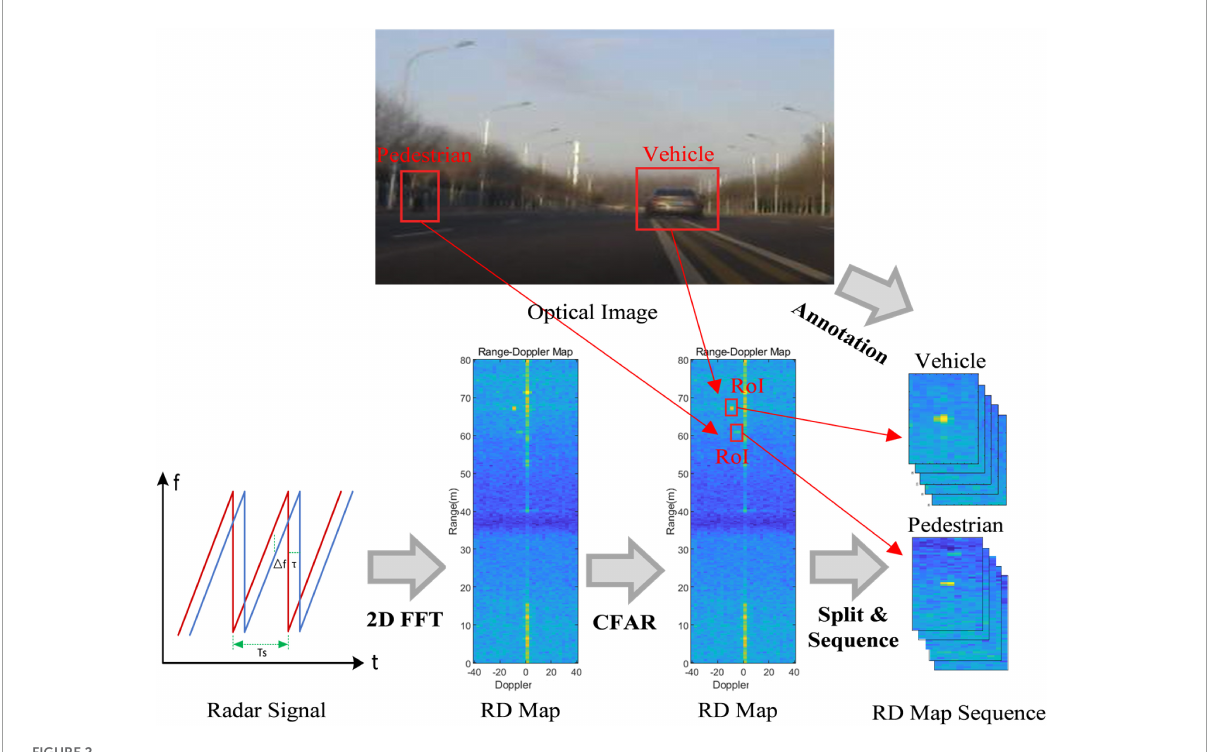
FIGURE2 The workflow of range-Doppler (RD) map sequence